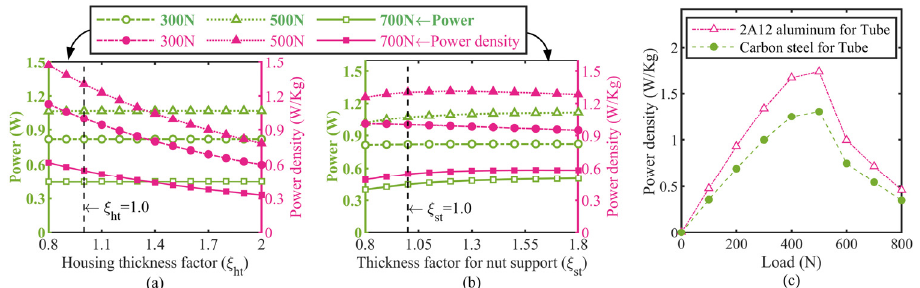
Figure 12. Simulated results of several critical parameters in actuator support components. Both power and power density versus: ( a ) housing thickness factor, ( b ) nut support thickness factor, ( c ) material of tube in housing.